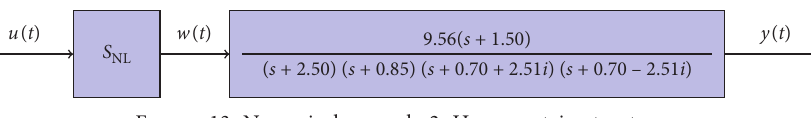
Figure 13: Numerical example 2: Hammerstein structure. Table 5: Ranking of estimated linear models for numerical example 2 (Hammerstein system). Models 4 p , 3 z /5 p , and 4 z /5 p have been excluded since their MDL values were very high.